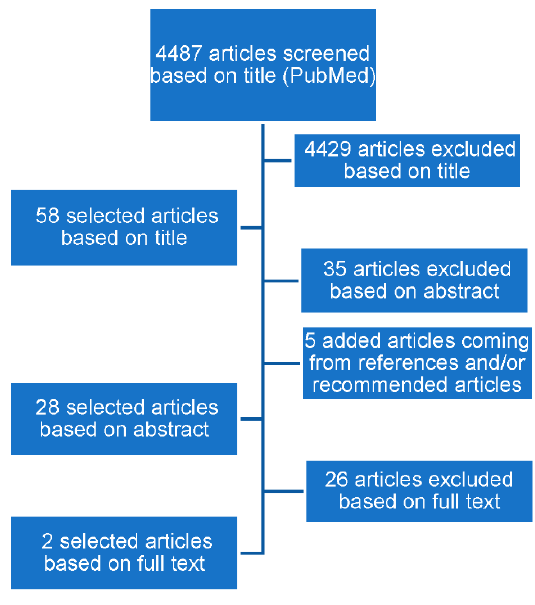
Figure 1. Literature search